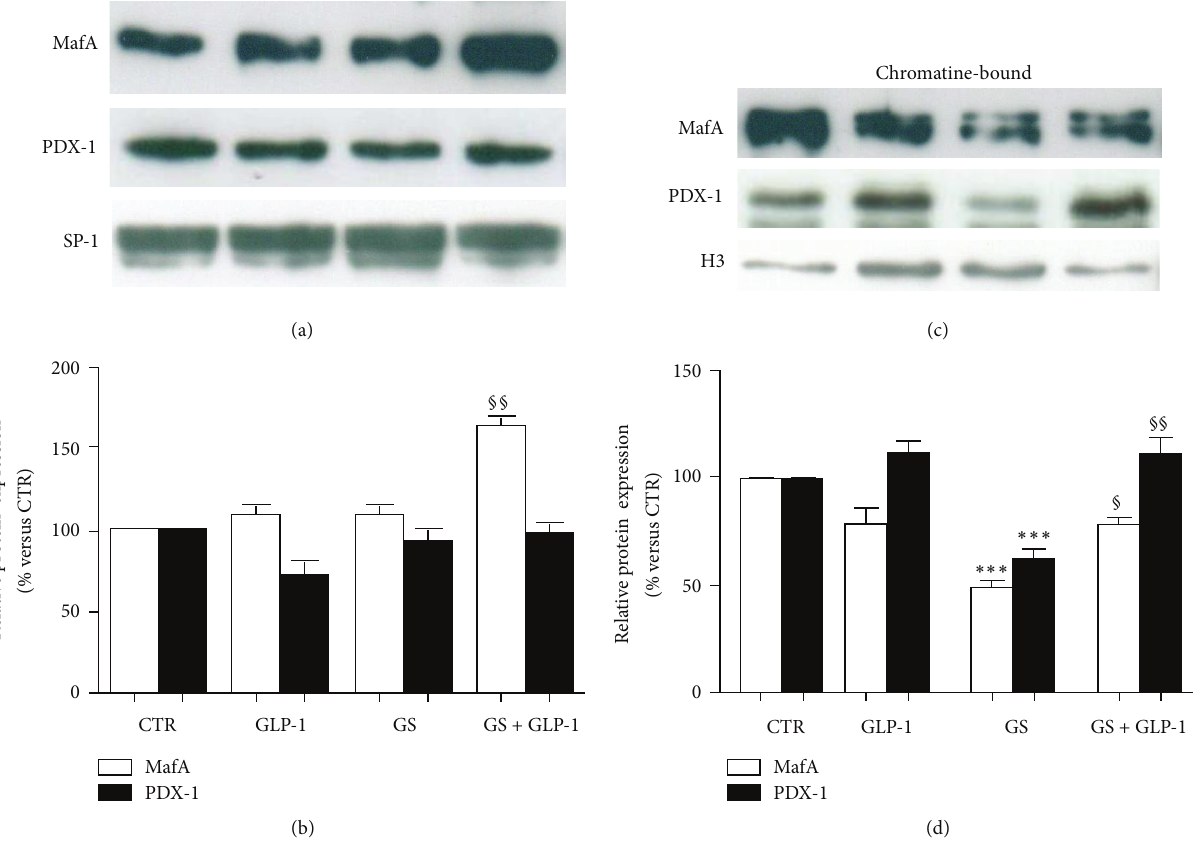
Figure 7: Effects of AGEs on nuclear distribution of MafA and PDX-1. Western blot analysis of nuclear soluble (a-b) and chromatin-bound (c- d) localization of MafA and PDX-1. (a) Representative western blot of three different experiments. SP-1 amounts were analyzed as a loading control. (b) Quantification of densitometries of western blot bands. Data were represented as percentage change from CTR level (100%) ( 𝑛 = 3 ). (c) Representative western blot of three different experiments. Histone H3 (H3) amounts were analyzed as a loading control. (d) Quantification of densitometries of western blot bands. Data were represented as percentage change from NGS level (100%) ( 𝑛 = 3 ). ∗∗∗ 𝑃 < 0.001 versus CTR; § 𝑃 < 0.05 and §§ 𝑃 < 0.01 versus